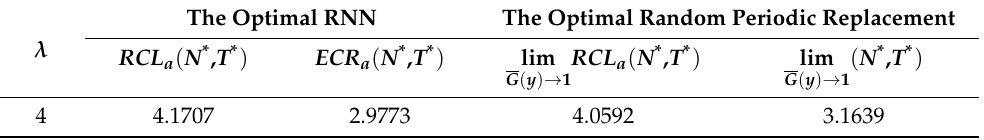
Table 3. The performance illustration of the